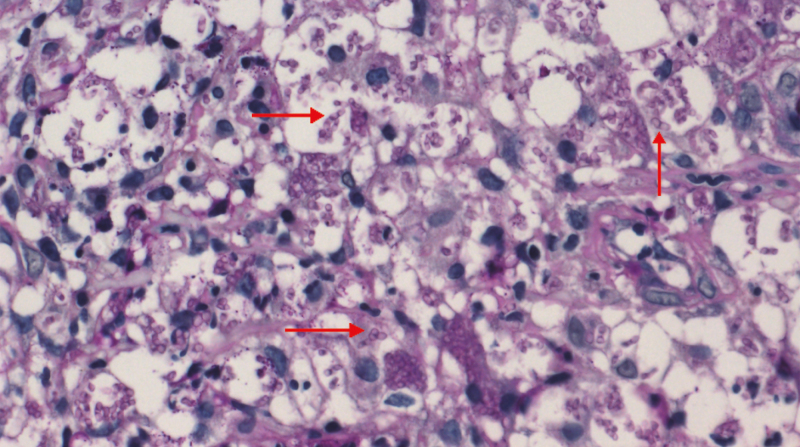
PAS staining of colon ulcers tissue showed revealed some intracellular and extracellular yeasts, elongated, and septate forms (arrow) (magnification × 400).